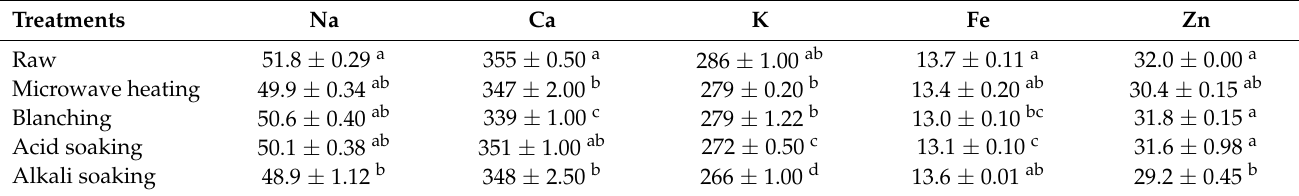
Table 3. Mineral composition of raw and processed cabbage powder (mg/100